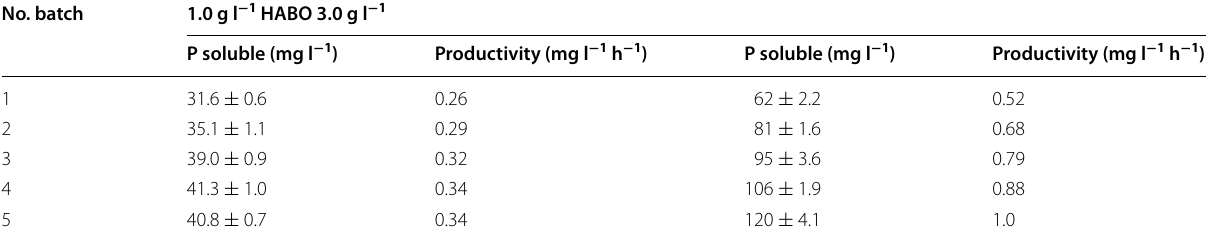
Values are means of three replicates